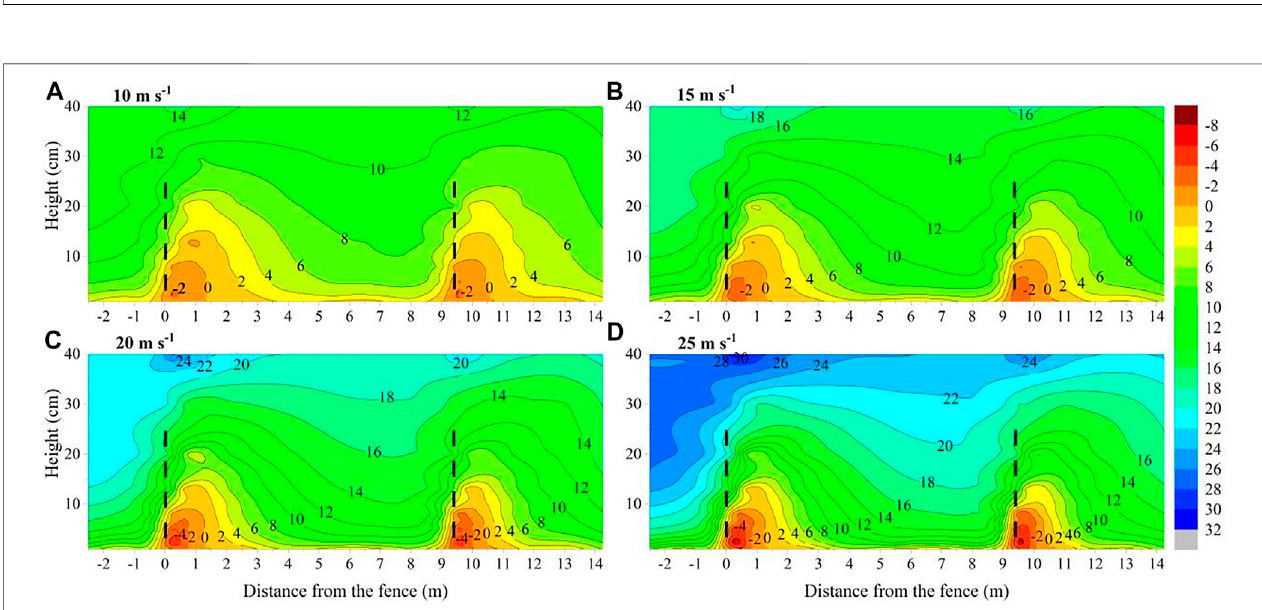
FIGURE 6 | Velocity contours (m s − 1 ) in the vicinity of the double-row straight-installed plates (SIPs) under different free-stream wind velocities. The negative wind velocities represent recirculated air fl ow, and the dash line shows the position of sand fences.